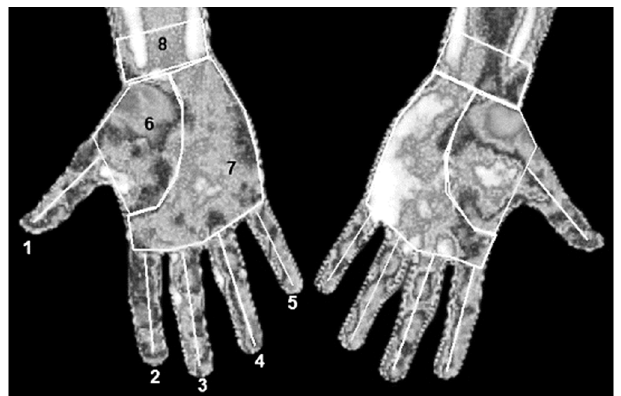
Figure 2. Regions of interest determined. ( 1 ) Thumb; ( 2 ) Index finger; ( 3 ) Middle finger; ( 4 ) Ring finger; ( 5 ) Little finger; ( 6 ) Thenar eminence; ( 7 ) Palm without thenar eminence; ( 8 ) Wrist.